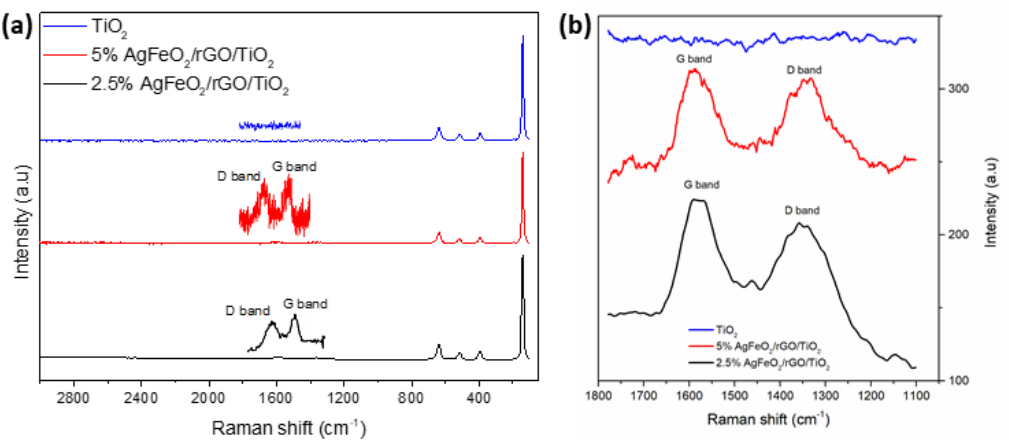
Figure 3. ( a ) Raman spectra of TiO 2 , 2.5% and 5% AgFeO 2 / rGO / TiO 2 . ( b ) Magnified view of D and G bands for respective samples.